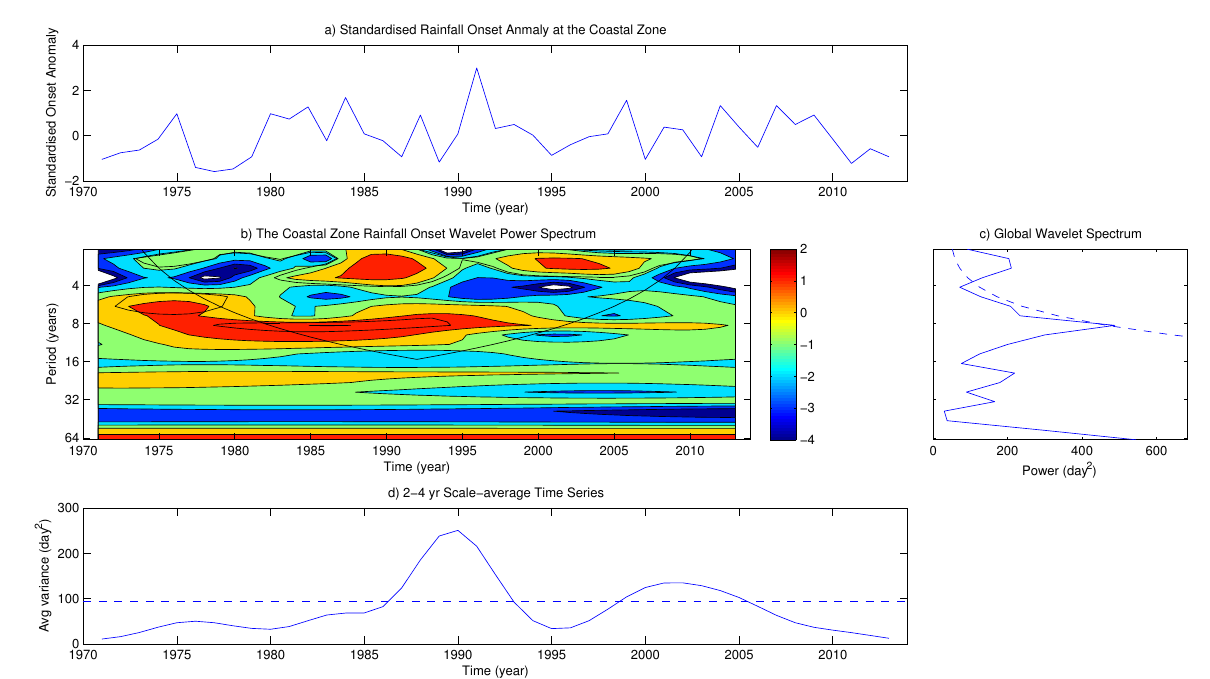
Figure 12. Interannual variability of rainfall onset dates for the coastal zone using wavelet analysis. ( a ) Standardized anomaly of onset; ( b ) as in Figure 6; ( c ) the same as in Figure 6; ( d ) the same as in Figure 6; the dashed line shows the 95% confidence